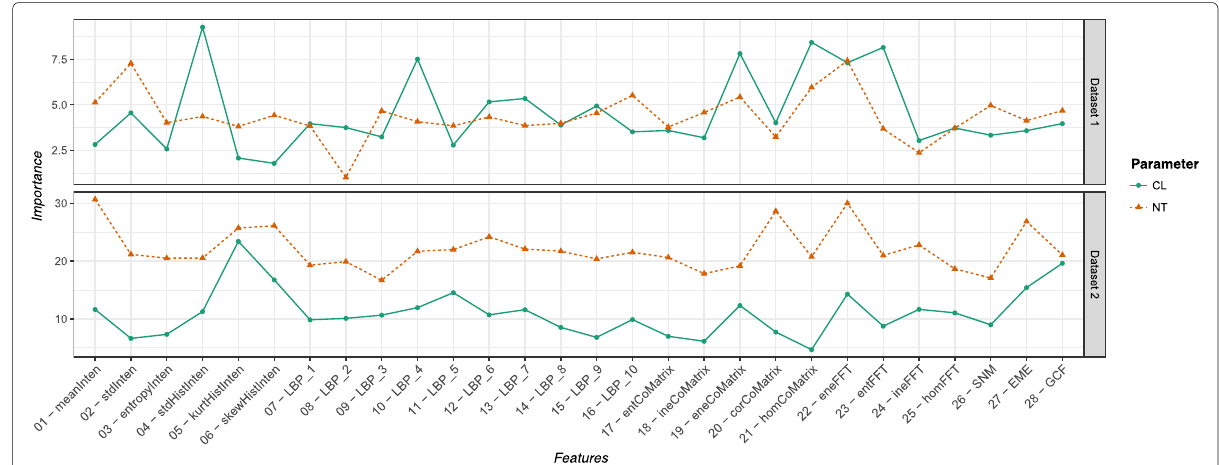
Fig. 7 Features importance extracted from RF models, to both datasets and CLAHE hyperparameters